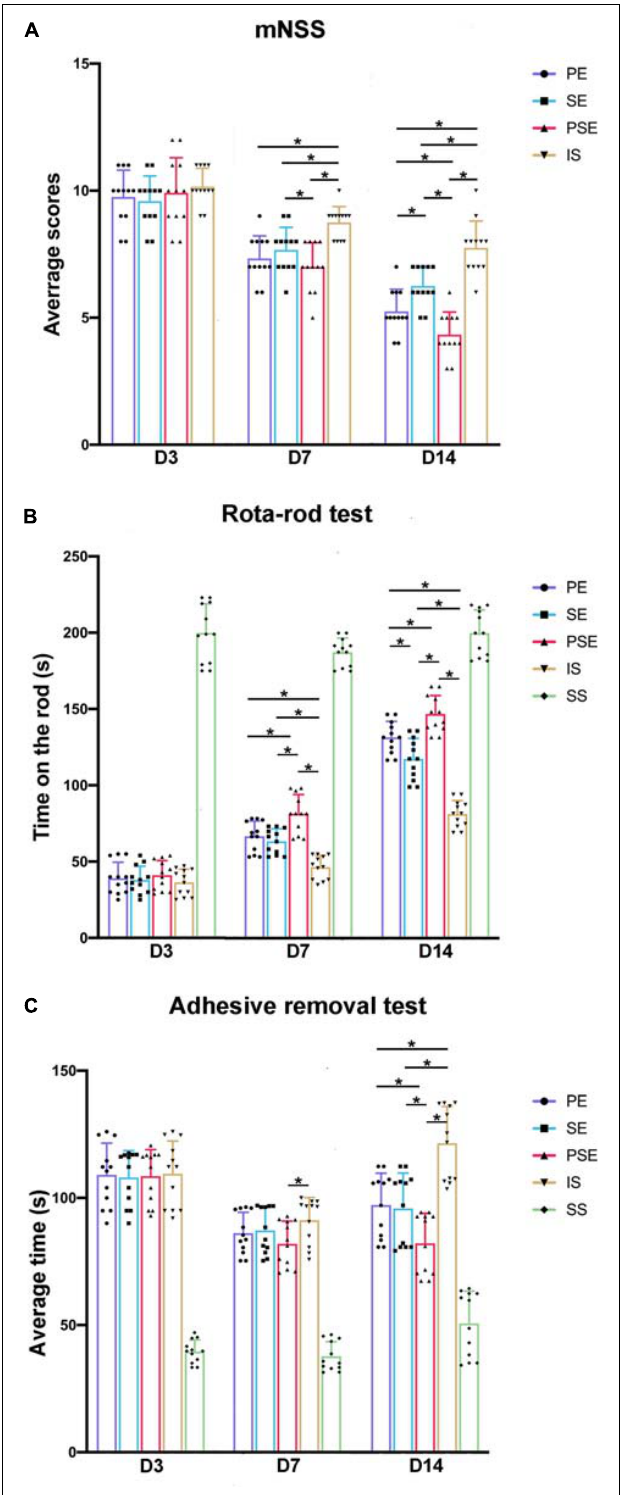
FIGURE 2 | Behavioral tests. The results of the modified Neurological Severity Score (mNSS) (A) rota-rod test (B) and adhesive removal test (C) on 3, 7, and 14 days of PE, SE, PSE, IS, and SS group. n = 12. Data are expressed as mean ± SEM; * P <